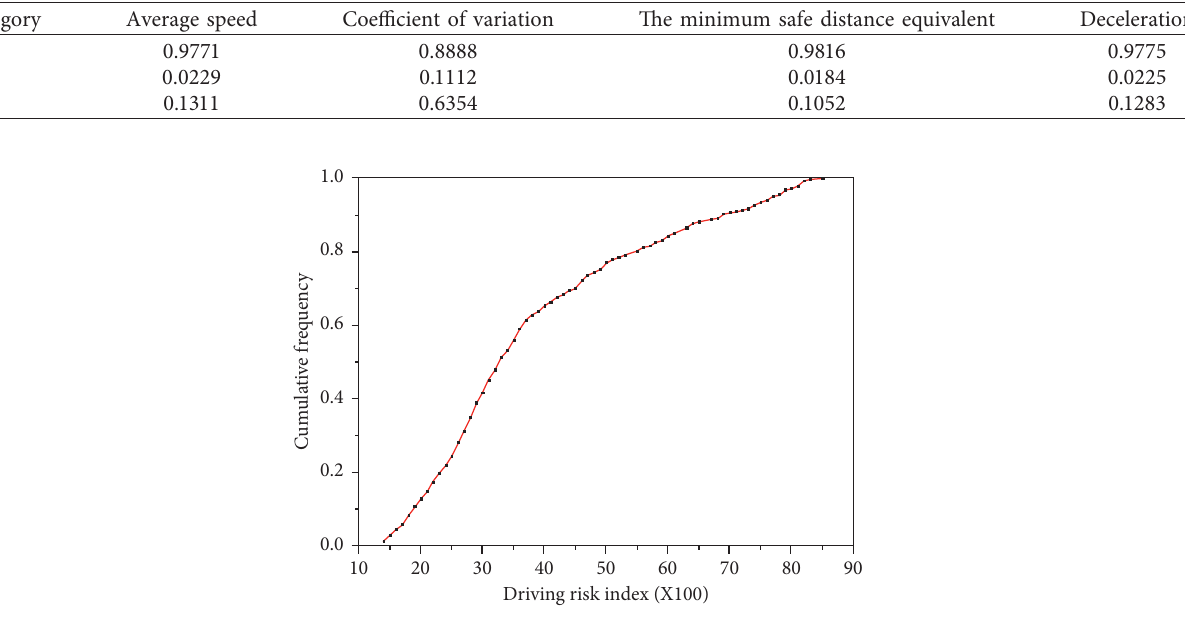
Figure 8: cumulative frequency distribution of the driving risk index. Table 4: Driving risk index division.